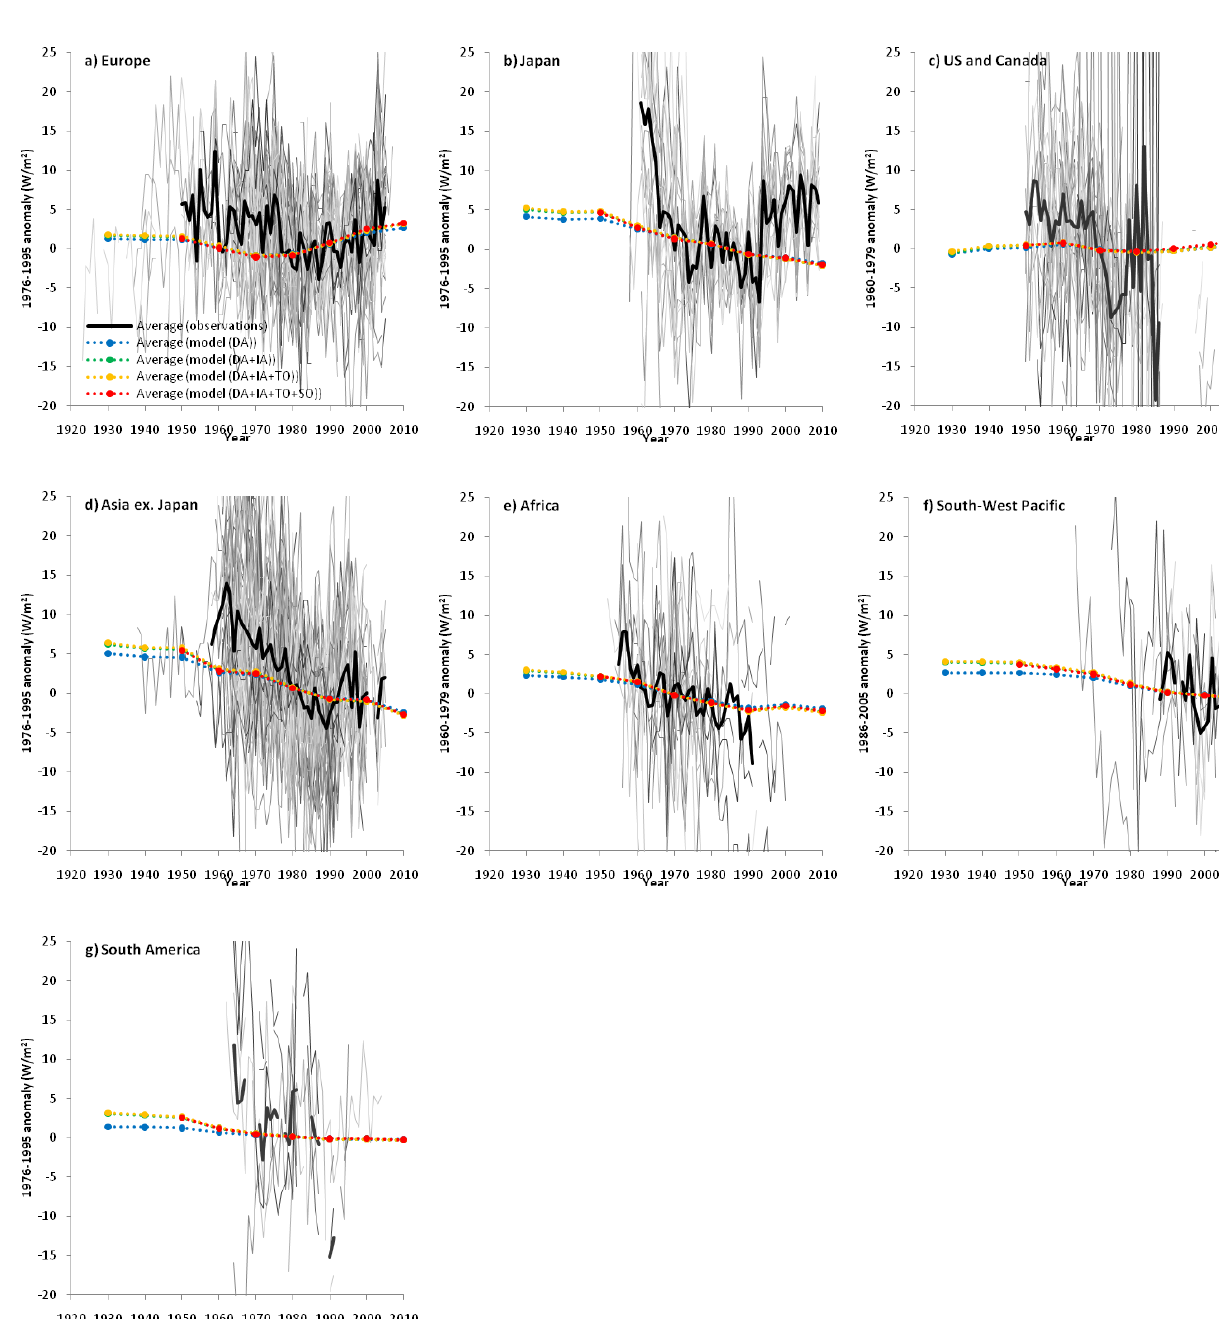
Figure 13: Model-data comparisons for the total radiation at the surface over seven world regions. Observational records have been obtained from the GEBA dataset (Ohmura et al., 1989; Gilgen et al., 1998; Gilgen and Ohmura, 1999; Ohmura, 2009; Wild, 2009) and those for Japan from A. Ohmura (2 November 2010, personal communication). DA, IA, TO, and SO denote direct aerosols, indirect aerosols, tropospheric O 3 , and stratospheric O 3 , respectively. Note that observed annual-mean records are shown only when there are five or more records within the region in a particular